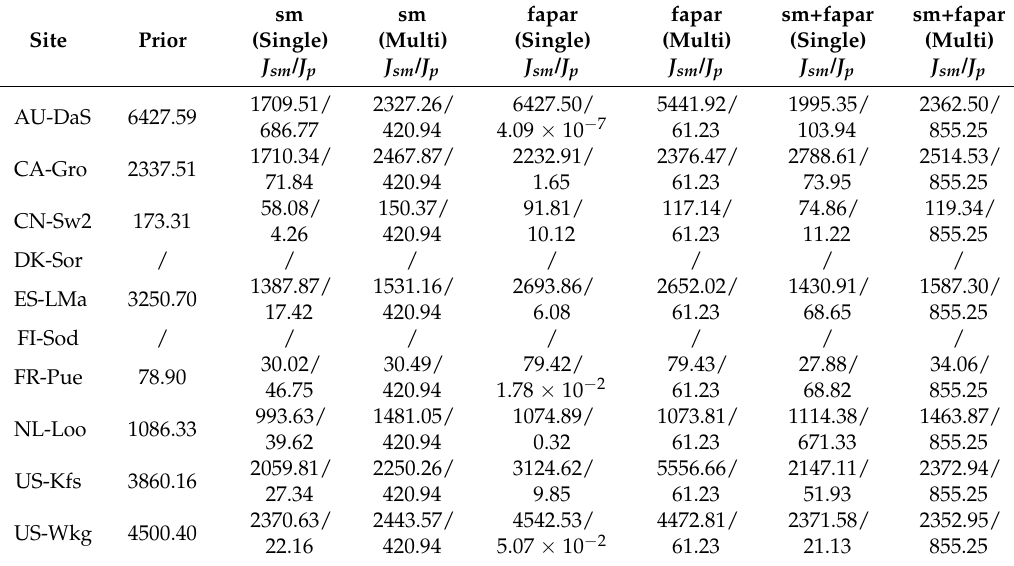
Table 3. Cost function values for soil moisture ( J sm ) and parameters ( J p ) for prior and different assimilation experiments, ‘sm’ with soil moisture only, ‘fapar’ with FAPAR only, ‘sm+fapar’ with soil moisture and FAPAR data combined, ‘multi’ denotes multi-site assimilation, and ‘single’ denotes single-site assimilation.